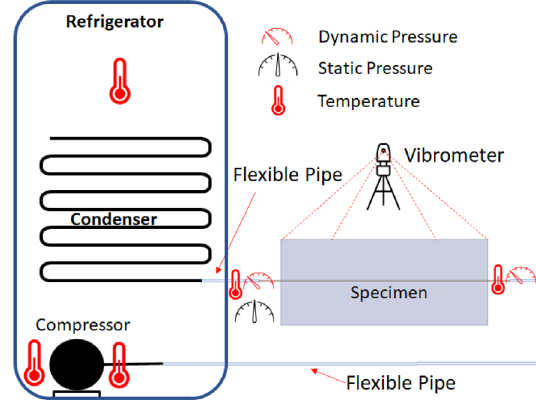
Figure 7. Bench developed for testing with segments.